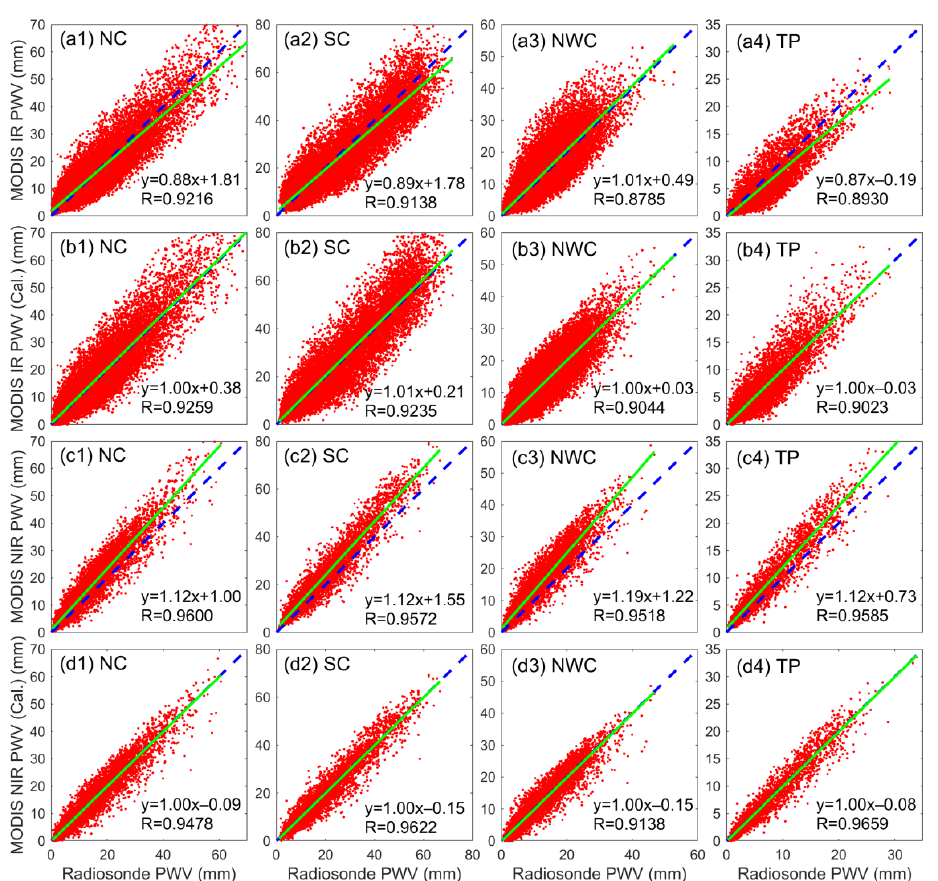
Figure 5. Scatterplots of the MODIS-derived IR/NIR PWV values with and without calibration over the period of 2011 – 2017 in the four areas in China, where ( a1 – b4 , c1 – c4 ) are the comparison of MODIS IR/NIR and GNSS PWV, and ( b1 – b4 , d1 – d4 ) are the comparison of calibrated MODIS IR/NIR and GNSS PWV.